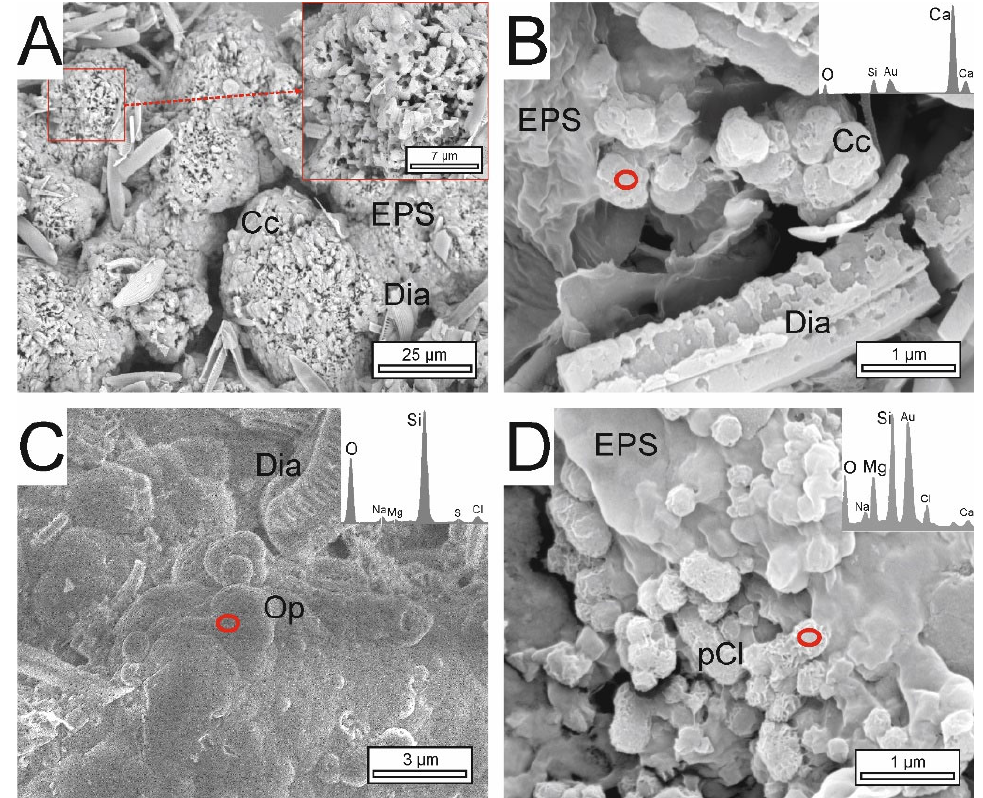
Figure 10. New minerals identified in the following field emission scanning electron microscope (FE-SEM) checkups after two months of running microcosms. All of them correspond to Salar de Pajonales incubations. ( A ) Highly porous calcite crystals (Cc) surrounded by dispersed Amphora frustules (Dia) from the PAJ-10 incubation. Zoomed view of a single crystal at the right side. ( B ) Calcitic grains emerging from denatured extracellular polymeric substances (EPS) enclosed by partially dissolved diatom frustules (Dia) from the PAJ-15 incubation. Spot (red circle) EDX shows Si enrichment. ( C ) Botryoidal opal aggregates (Op) near Amphora frustules (Dia) from the PAJ-2.1 incubation. Spot (red circle) EDX spectra in the upper right. ( D ) PAJ-15 incubation showing similar grains as in ( B ) emerging from a glutinous EPS. In contrast to ( B ), spot (red circle) EDX confirmed magnesium silicate composition of proto-phyllosilicate minerals (protoclay-pCl). Note the internal nanometric fiber-like